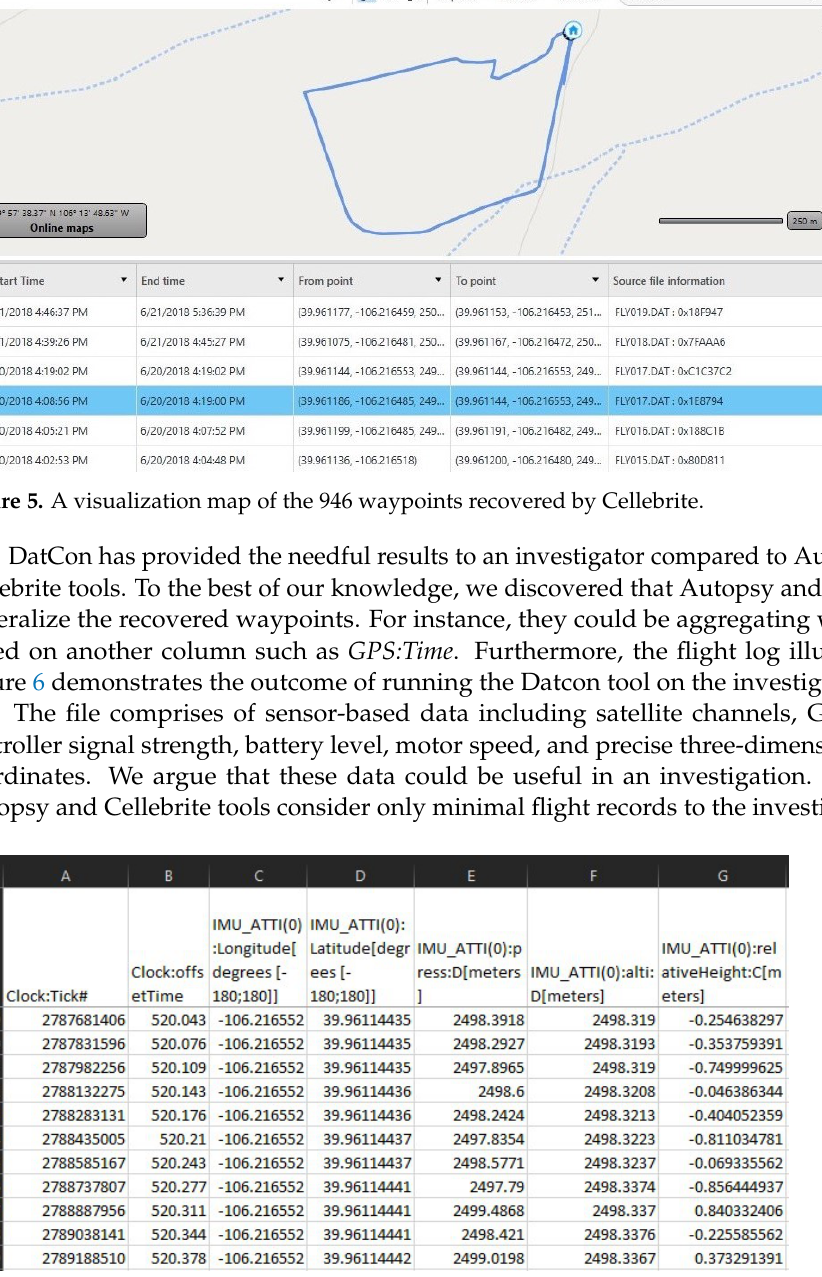
Figure 6. A screenshot of the decrypted .DAT file in .CSV